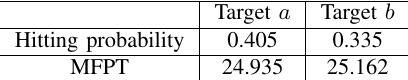
The hitting probability and the MFPT in a two target